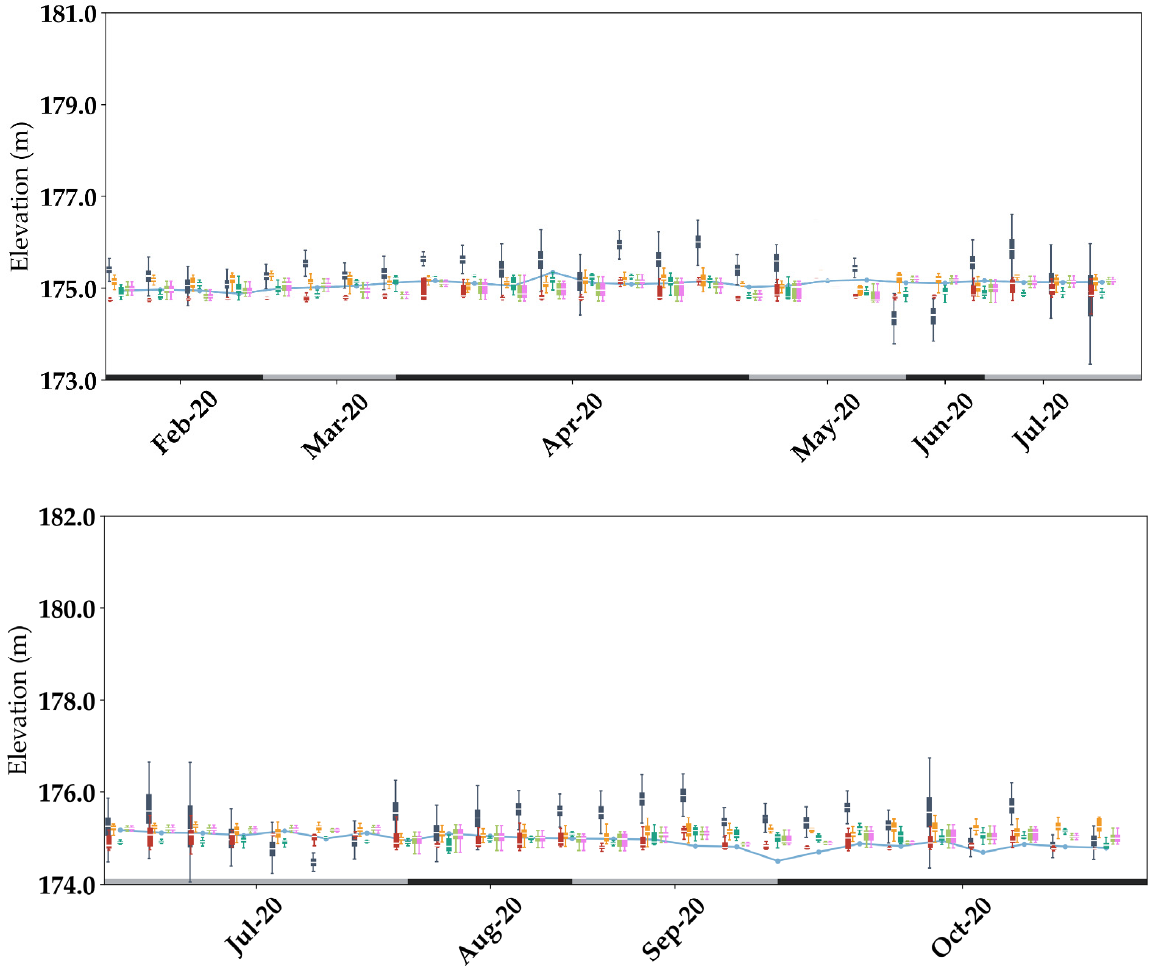
Figure A6. Boxplot by track of the original estimated elevations by GEDI over Lake Erie and the five tested models presented in Section 3.1.3. The green line represents in situ elevations. RF CV represents the 5-fold cross-validation results over Lake Erie. RF Huron → Erie , RF Ontario → Erie , RF Michigan → Erie , and RF Superior → Erie represent the results of the models trained over Lakes Huron, Ontario, Michigan, and Superior, respectively, applied over Lake Erie.